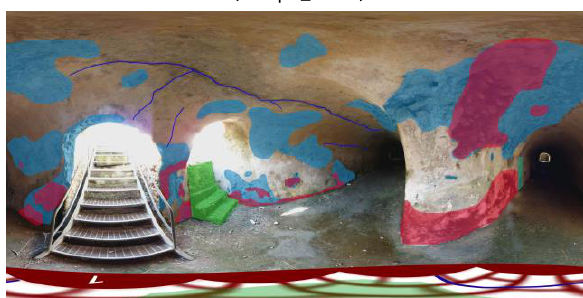
Figure 8. Equirectangular mapped image of the Cryptoporticus ( n3 Sph_Map) in the photo-plane visualization